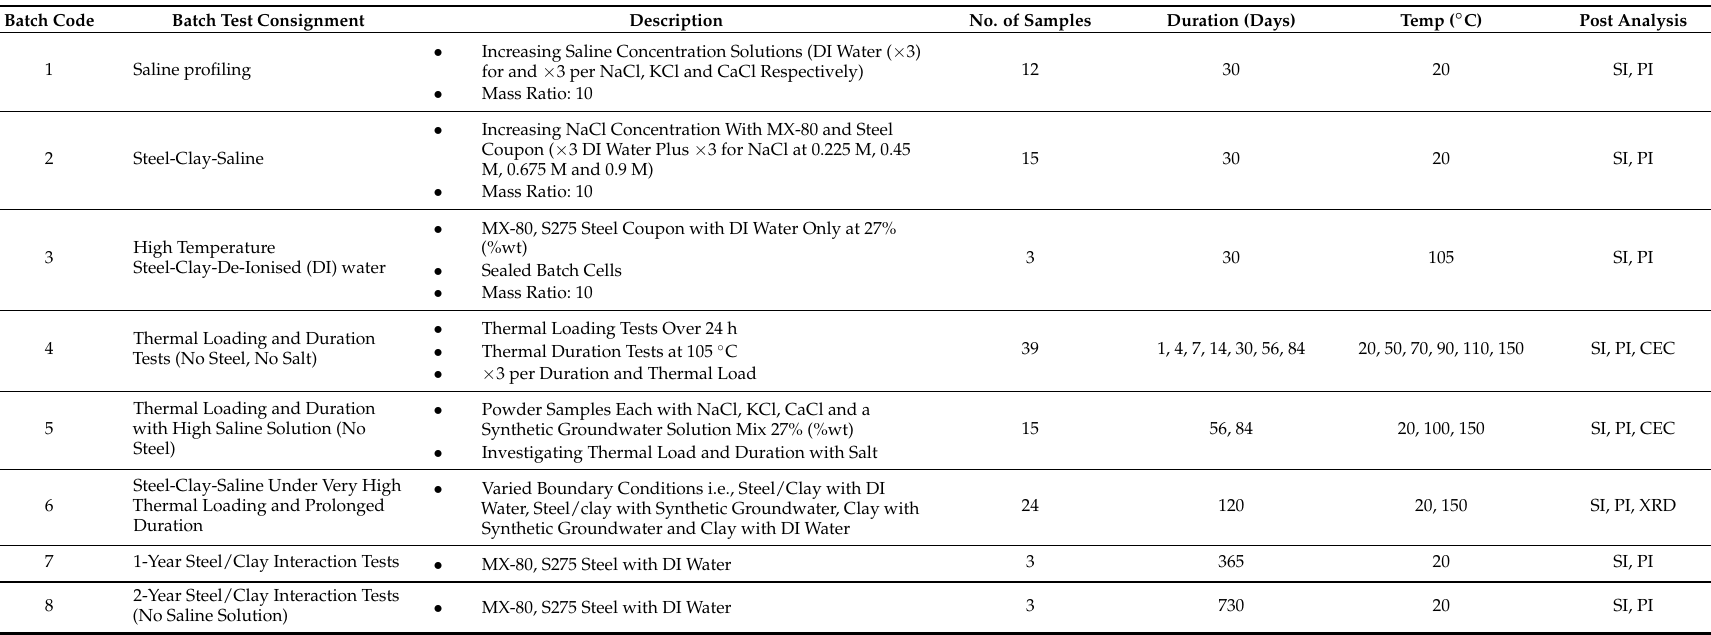
Table 2. Experimental Regime (PI: Plasticity index, SI: Swell index, CEC: Cation exchange capacity, XRD: X-ray